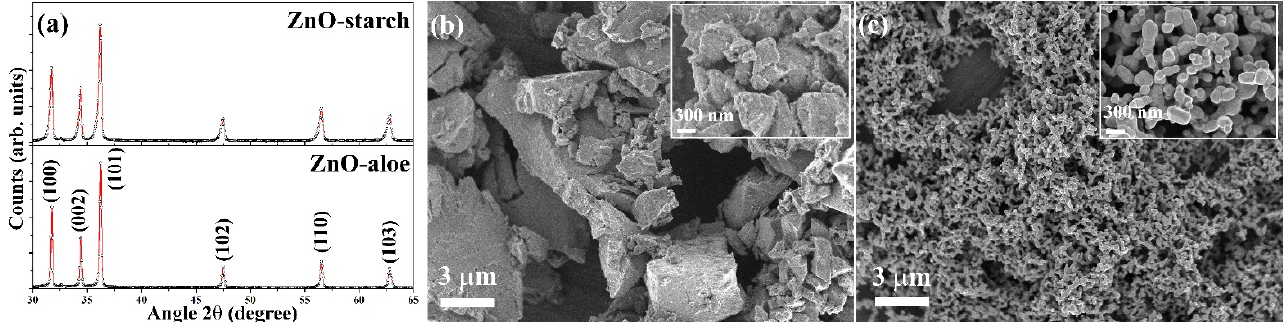
Figure 2. Characterization images of as-prepared ZnO-aloe and ZnO-starch powders: ( a ) X-ray diffraction pattern (showing the hexagonal wurtzite crystal structure of ZnO); ( b ) SEM images of ZnO-aloe at low magnification (inset: SEM images at high magnification); ( c ) SEM images of ZnO-starch at low magnification (inset: SEM images at high magnification).